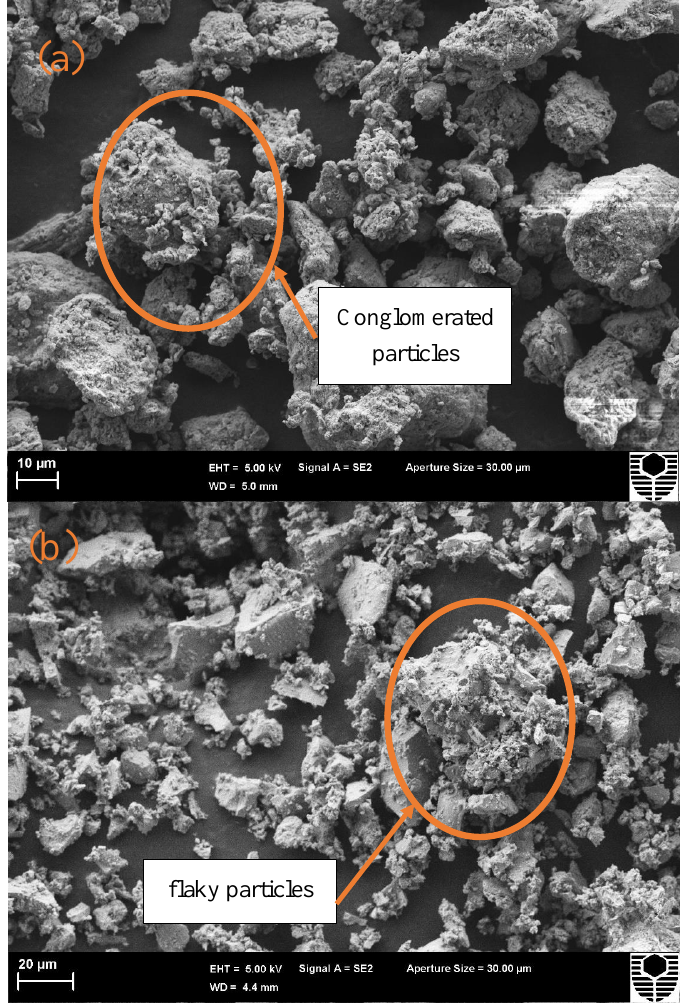
Figure 2. Scanning electron microscopic of the ( a ) Bentonite and ( b ) Portland cement (PC). Table 1. Characteristics of the used Type II PC [21].